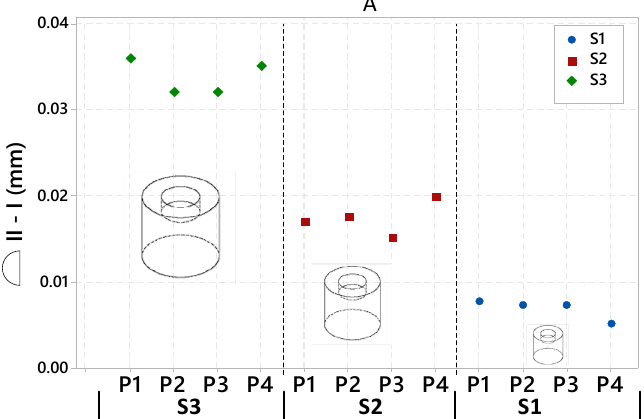
Figure A2. Stress relief effect depending on the feature nominal size for the 12 Shape A artifacts; S1–S3 part size .